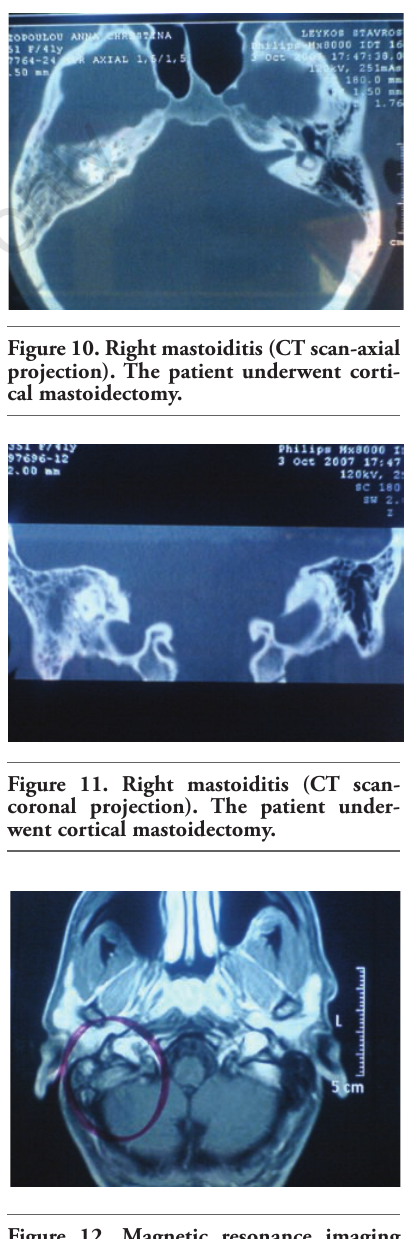
Figure 12. Magnetic resonance imaging scan of the previous patient. Please note the difference in the signal on the right (circle) compared to the left side.